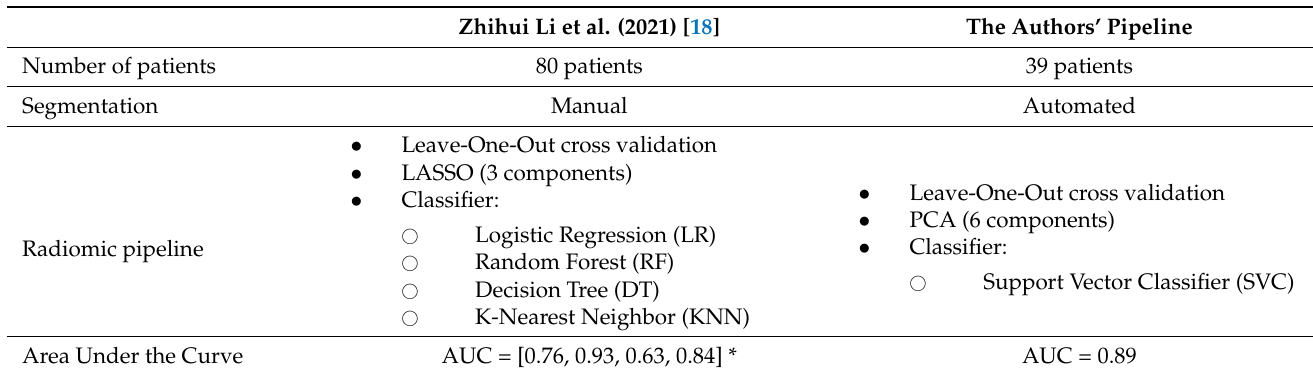
Table 4. Comparison between the authors’ pipeline and the state-of-the-art pipeline proposed by Zhihui Li et al. for the automated prediction of the TRG score. For both pipelines, the number of patients involved in the study, the segmentation procedure (manual/automated) used for the lesion ROI identification, the radiomic pipeline developed, and the resulting prediction scores expressed in terms of AUC are